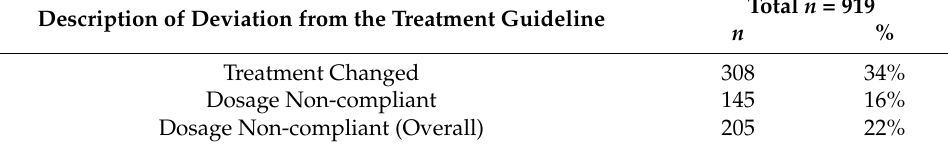
Table 3. Compliance characteristics of MDR/RR-TB patients registered from 2012 to 2018 in Uzbek- istan and assessed under the project of “Evaluation of the TB drug usage for treating MDR TB” (Continuation